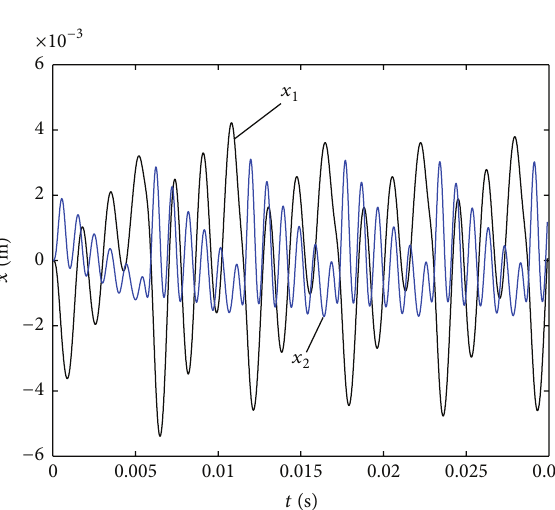
Figure 4: Natural mode of vibration of the two-degree-of-freedom system.